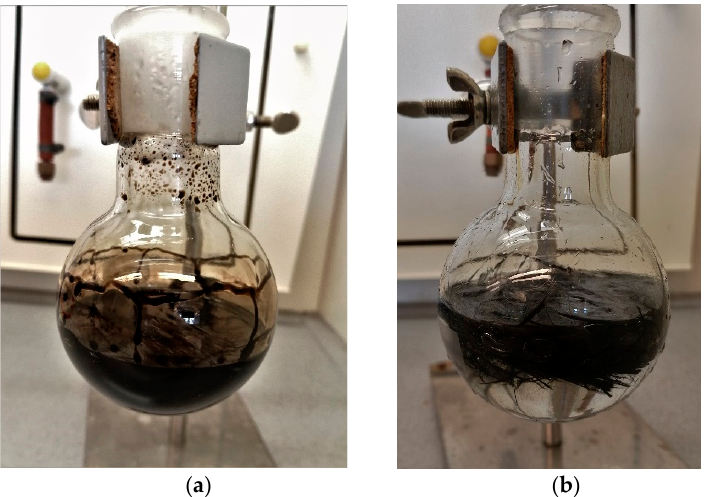
Figure 2. ( a ) Carbon/Epoxy sample during sulfuric acid digestion; ( b ) after the addition of Hydrogen Peroxide Description of what is contained in the second panel.